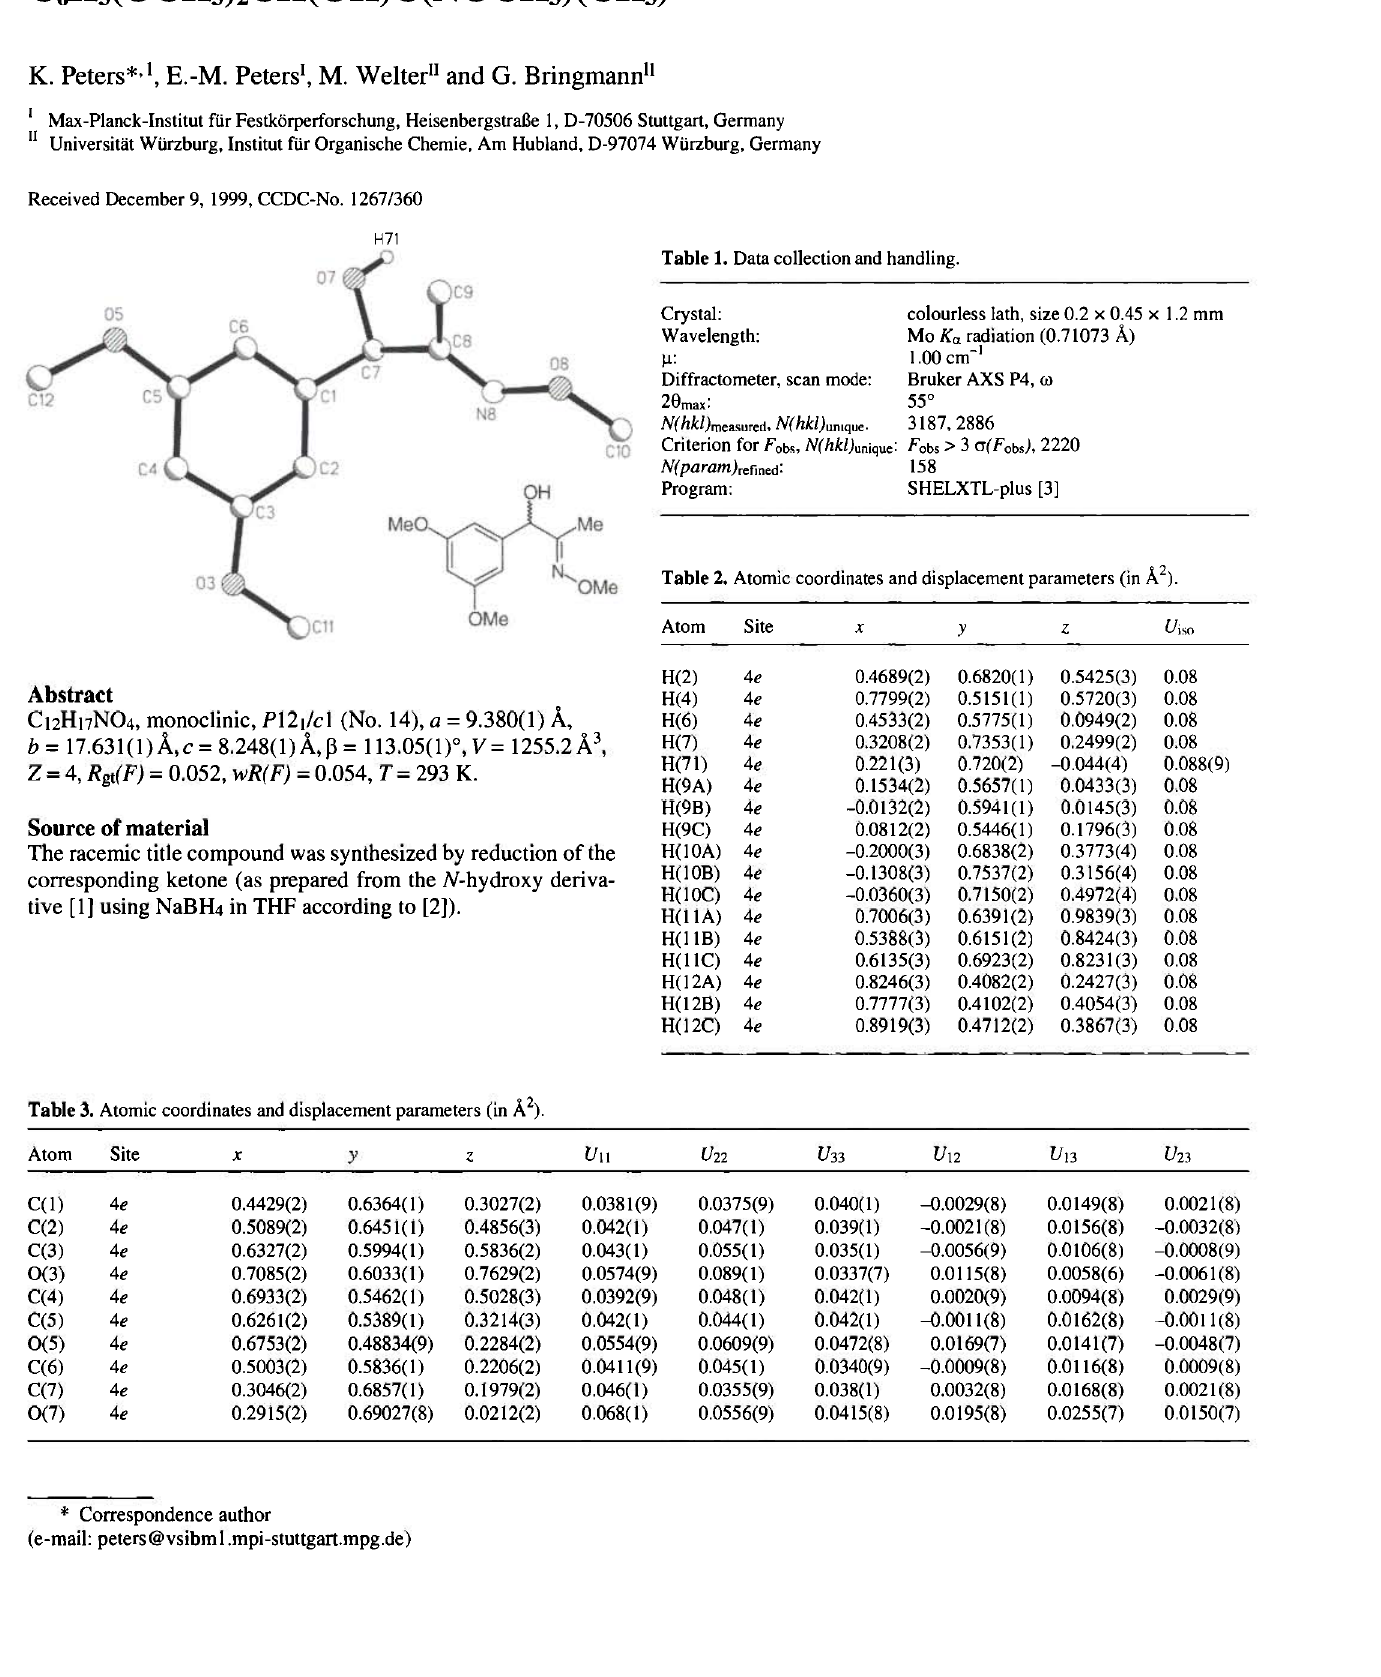
Table 1. Data collection and handling.